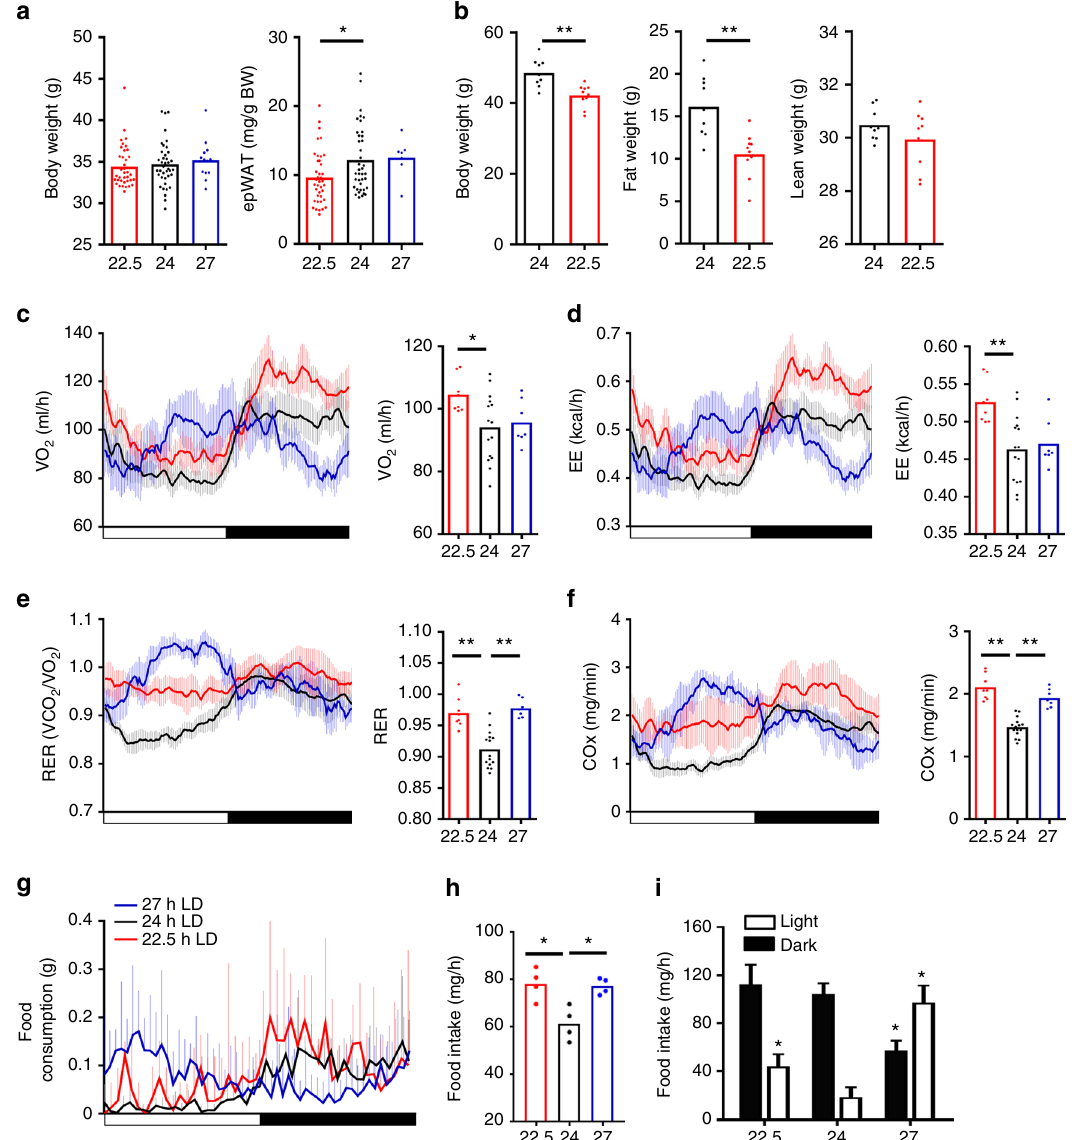
Fig. 2 Phase misalignment drives reduced energy ef fi ciency and metabolic disturbance. a Body weight and epididymal adipose tissue mass (epWAT) of mice maintained in 22.5, 24 or 27 h LD conditions for 17 week. epWAT was signi fi cantly lower in 22.5h LD mice compared with age-matched 24 h controls ( n > 7/group). b By 1 year of LD exposure, both body weight and whole-body fat mass were signi fi cantly lower in 22.5 h LD housed mice compared with matched 24 h LD mice ( n = 9 – 10/group). c – f Diurnal rhythms and mean values for oxygen consumption (VO 2 ; c ), energy expenditure (EE; d ), respiratory exchange rate (RER; e ) and carbohydrate oxidation (CO x ; f ) for mice maintained under 22.5, 24 and 27 h LD cycles ( n = 7 – 16/group). A signi fi cant increase in RER and CO x was evident in non-24 h LD housed mice. g – i Diurnal pro fi les of food intake ( g ) and mean intake/h ( h ) reveal signi fi cantly increased food consumption in mice maintained under either 22.5 or 27 h LD cycles compared with 24 h LD control. Mice housed under non-24h LD cycles also consumed more food during the light phase of the cycle ( i ). Diurnal pro fi les c – g re fl ect mean ± 95% CI. a , c – h ∗ p < 0.05, ∗∗ p < 0.01 one-way ANOVA with Dunnett ’ s post hoc test (vs. 24 h control group); b ∗∗ p < 0.01 Students t -test; i ∗ p < 0.05 vs. 24 h LD two-way ANOVA with Tukey ’ s post hoc